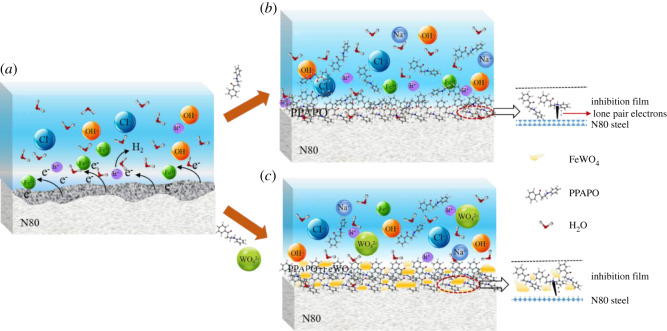
Inhibition effect of Na2WO4 and PPAPO on N80 steel in HCl solution: (a) HCl solution, (b) PPAPO and (c) PPAPO and Na2WO4.